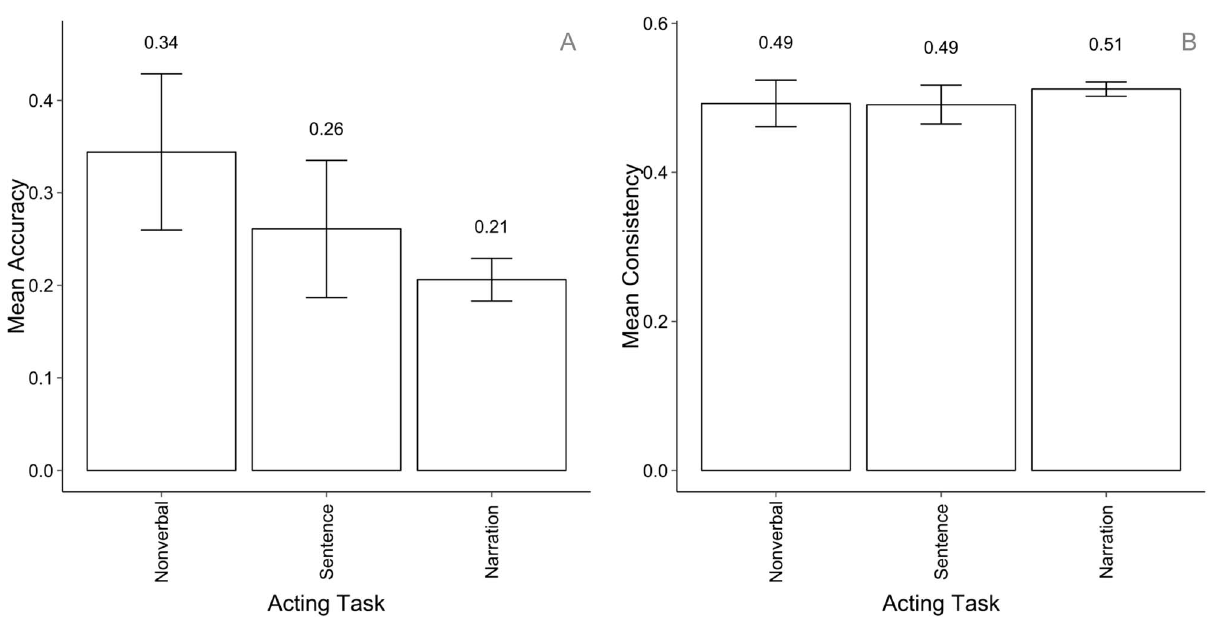
Figure 5. Emotion recognition accuracy across acting tasks for intended emotions (A) and consistency rates for perceived emotions (B) across acting tasks. All error bars represent 95% CI.